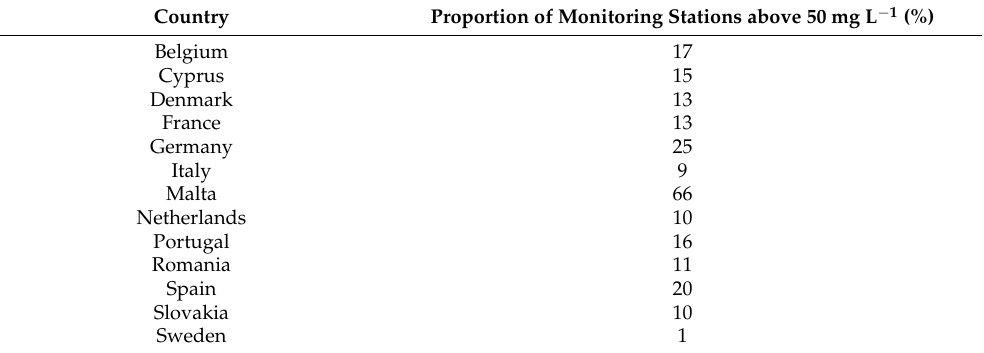
Table 1. Proportion of groundwater monitoring stations with concentrations above 50 mg L − 1 in some countries of the European Union during the reporting period 2012–2015 and 2016–2019. Source: Joint Research Centre of European